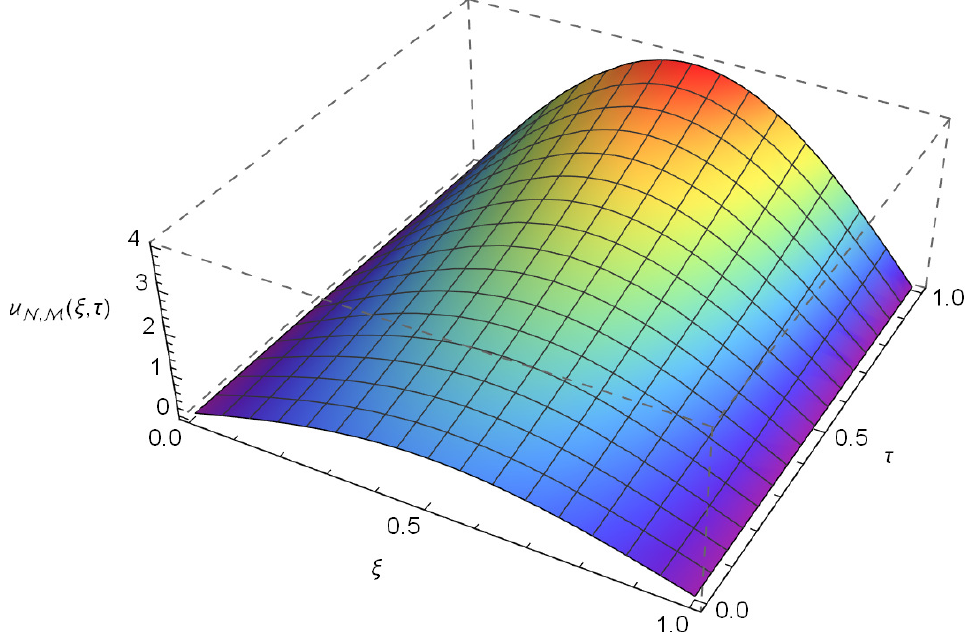
Figure 1. Numerical solution of the problem (30), where σ 1 = (cid:36) 1 = σ 2 = (cid:36) 2 = 0, ν = 0.5 and N = M = 16.